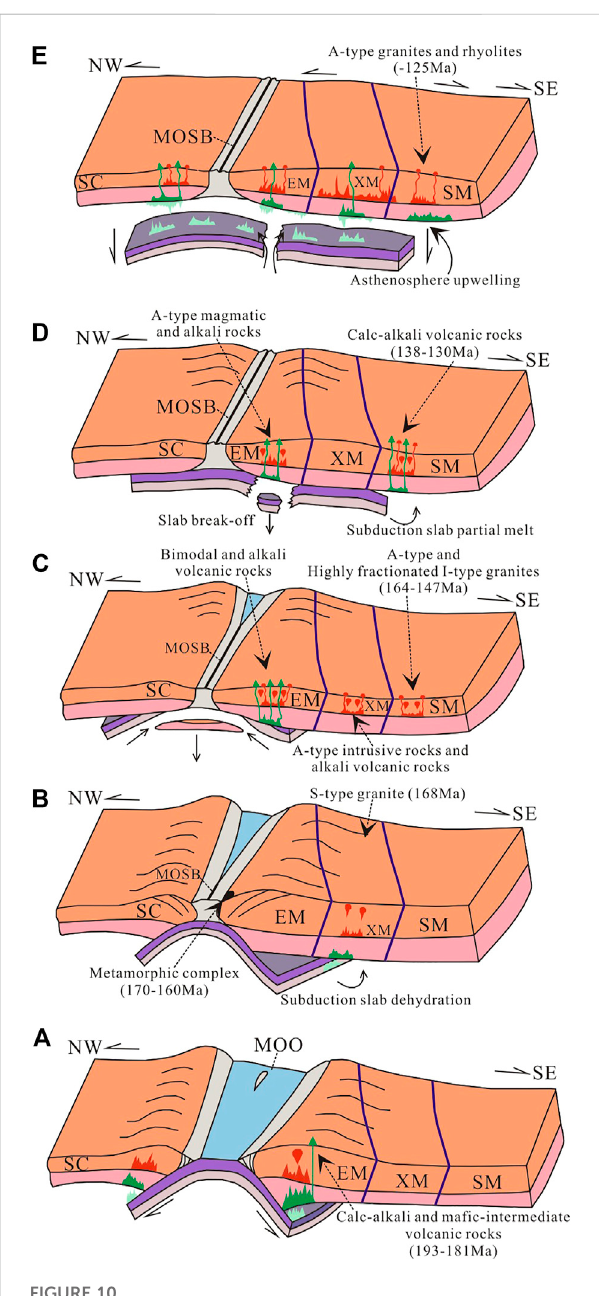
FIGURE 10 Schematic diagram (adapted from Zhang et al., 2020) showing a petrogenetic model for Late Mesozoic magmatic rocks in the southernGreatXing ’ anRange.SC,SiberianCraton;EM,ErgunaMassif; XM, Xing ’ an Massif; SM, Songliao Massif; MOO, Mongol-Okhotsk Ocean; MOSB, Mongol-Okhotsk Suture